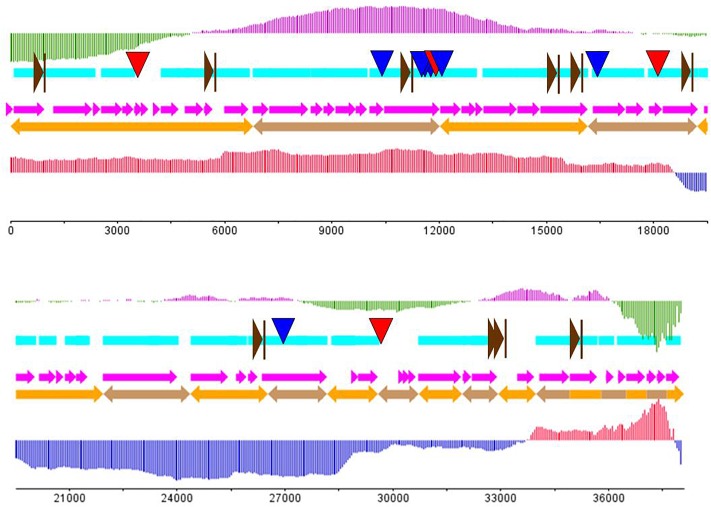
The putative genome draft of phage AJO2. Sky-blue band indicates gene-encoding regions in the AJO1 genome; orange arrows indicate assembled scaffolds and pink arrows represent predicted ORFs in the AJO1 genome. The GC skew is calculated as (G-C)/(G+C) and the GC plot shows GC% content. The upper vertical line with fixed intervals represents the GC skew (purple for positive and green for negative); the lower vertical lines represent the GC plot (red for above-average and blue for below-average). The downward arrows give the locations of repeats (blue for LINE and red for SINE). The rightward brown arrows indicate the putative promoters.